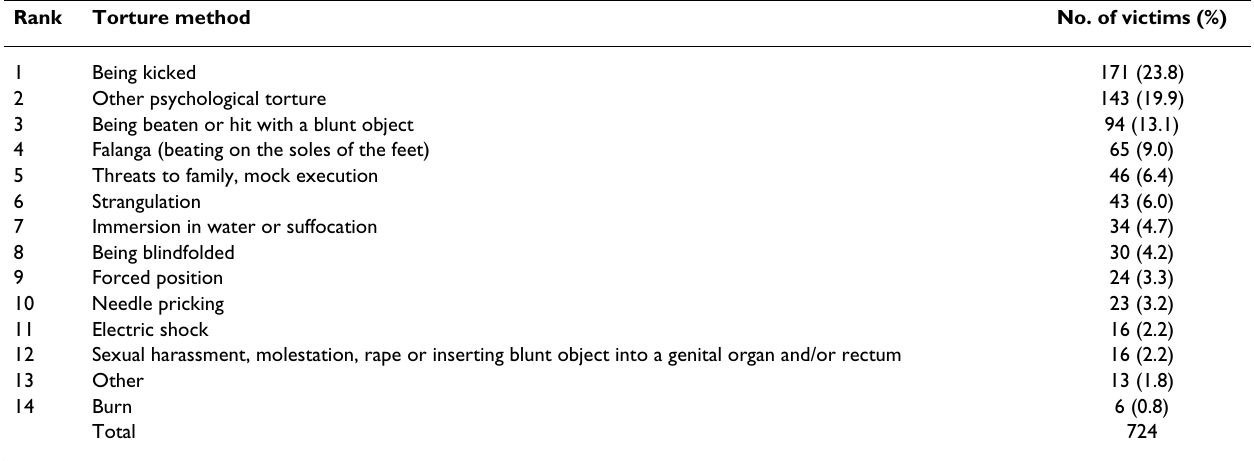
Table 3: Torture methods reported by the study participants